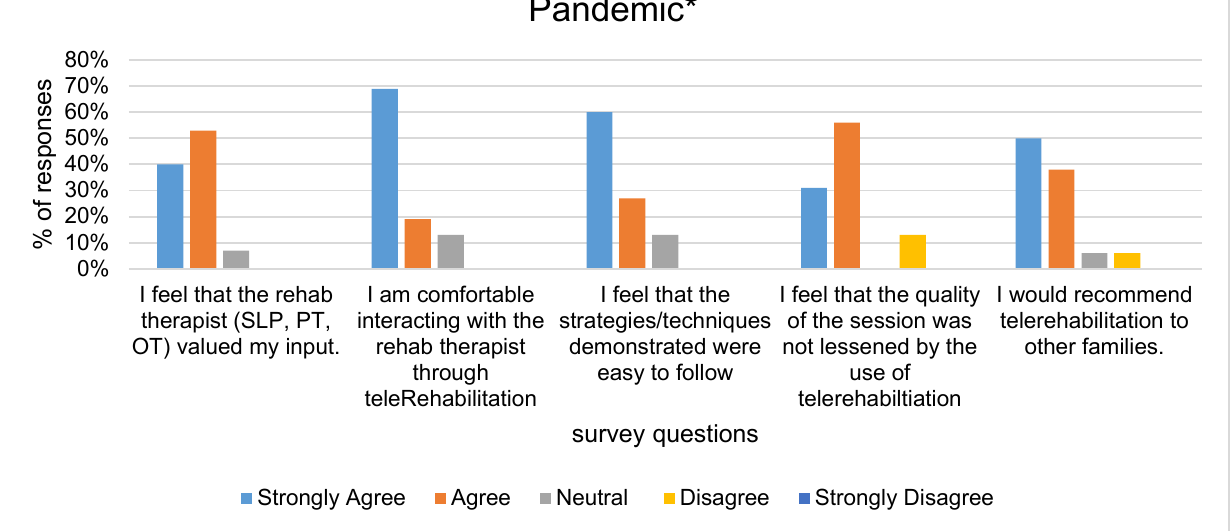
Note . *data collected from 2015 through